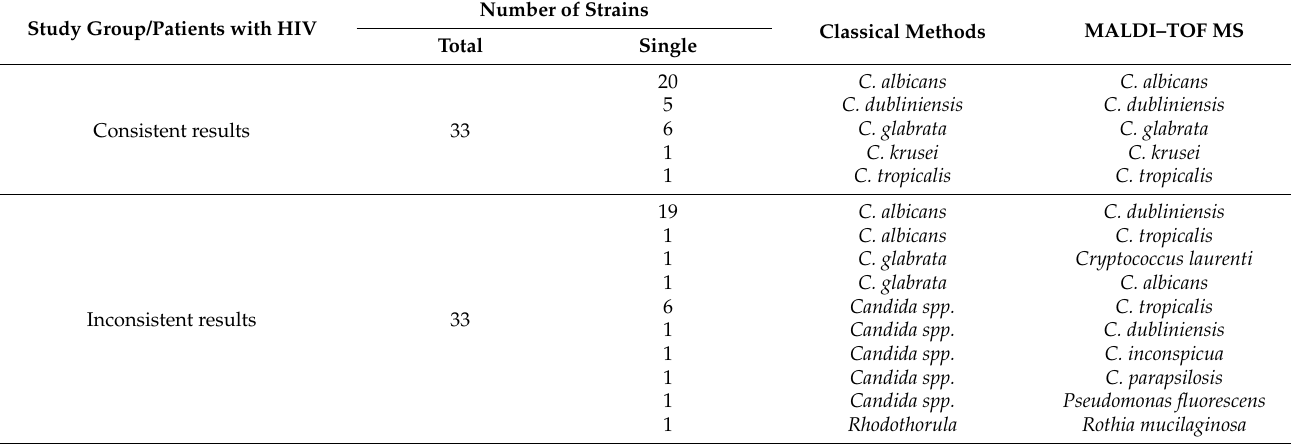
Table 1. Comparison of results of fungi identification in the study group (people infected with HIV). Study Group/Patients with